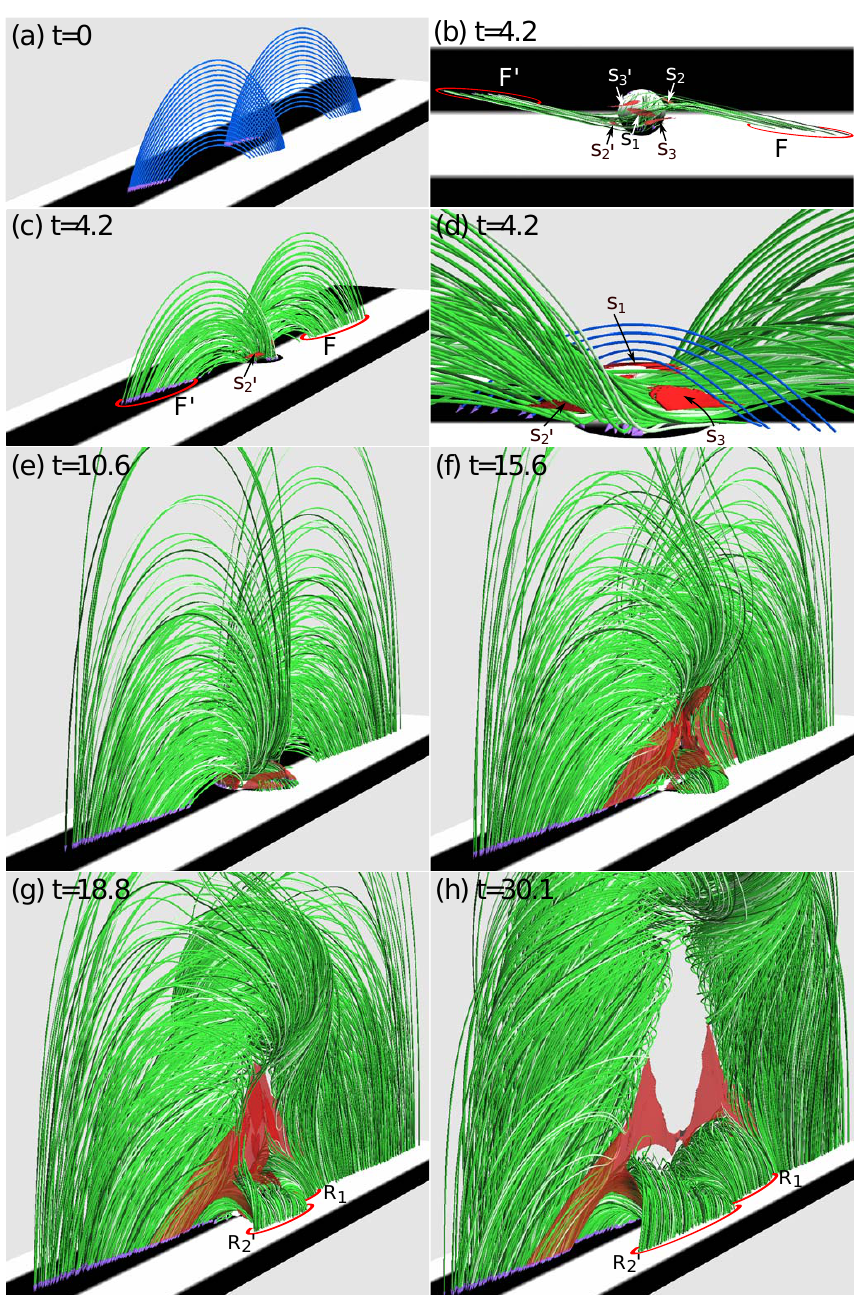
Figure 57: Three-dimensional visualization of the case of a successful eruption by Kusano et al. (2012). Each subset represent a birds eye view (a, c, e–h), top view (b), and enlarged side view (d) of the magnetic field at different times. Green tubes represent magnetic field lines with connectivity that differs from the initial state. Selected magnetic fields in the initial state and those retaining the initial connectivity are plotted by blue tubes in (a) and (d), respectively. Red isosurfaces correspond to intensive current layers, and ray scales (white, position) on the bottom plane indicate the distribution of the 𝑧 component of magnetic field 𝐵𝑧 . Image reproduced with permission, copyright by